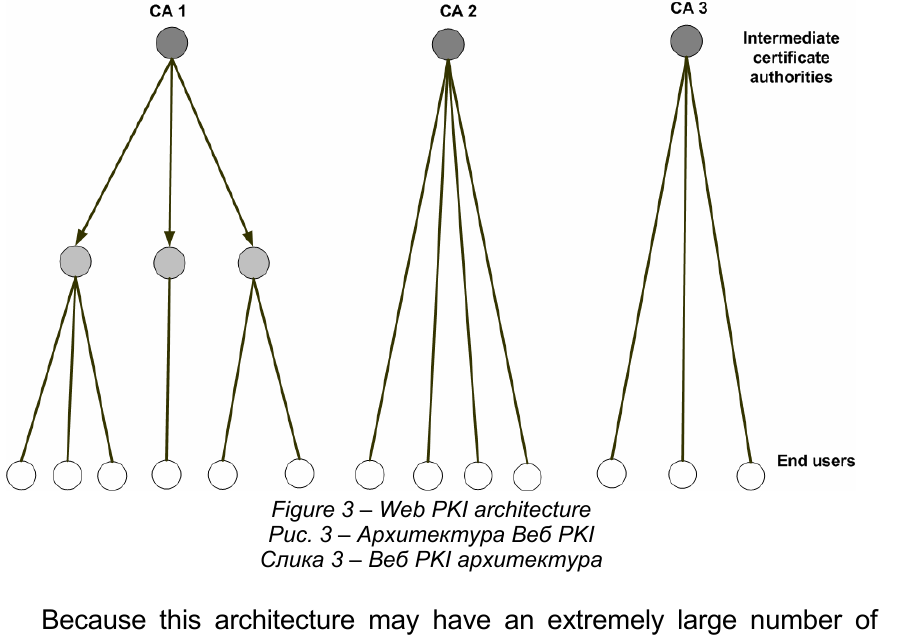
Figure 3 – Web PKI architecture Рис . 3 – Архитектура Веб PKI Слика 3 – Веб PKI